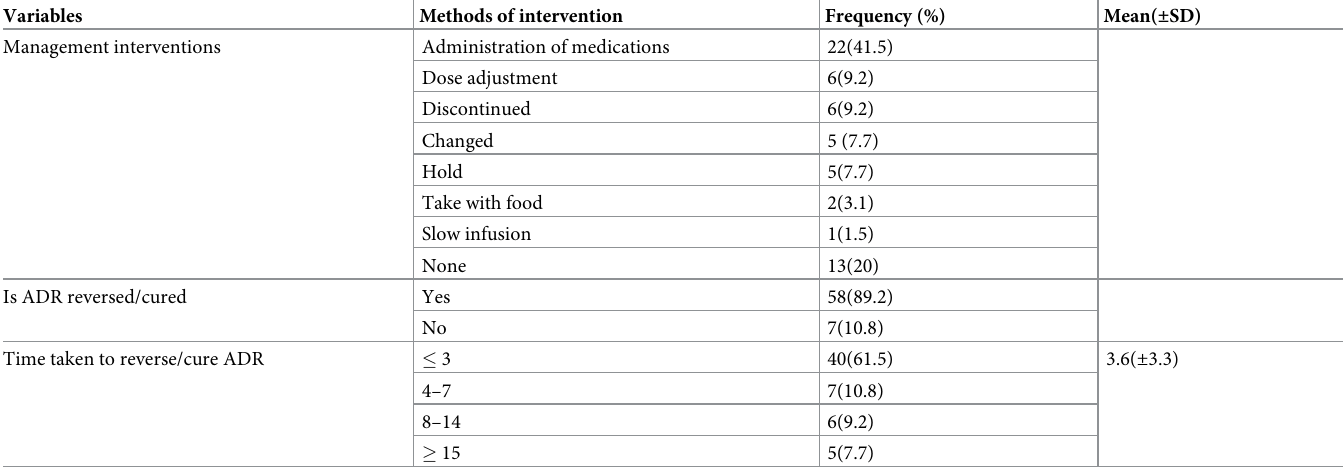
Table 8. Adverse drug reaction management interventions (N =